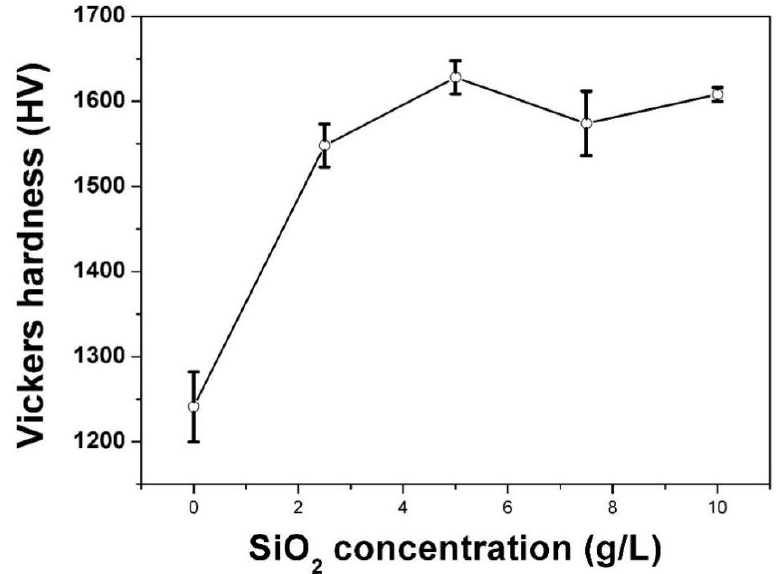
Figure 5. Microhardness of unsealed MAO film and MAO films sealed by SiO 2 nanoparticles.